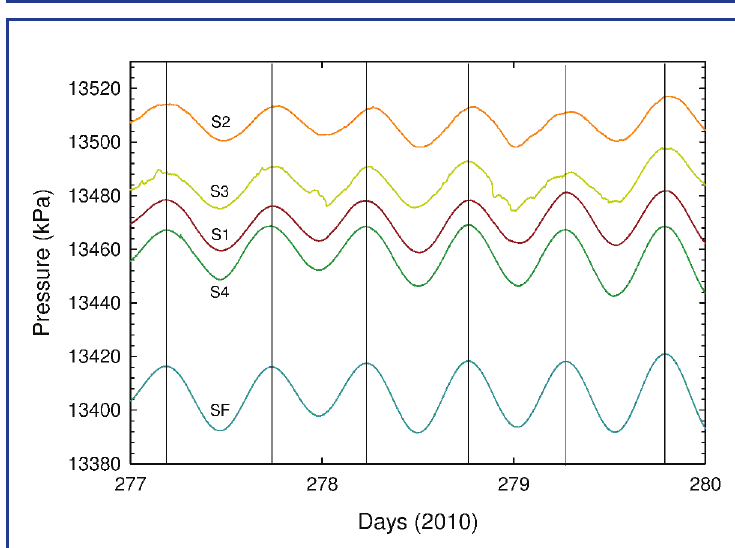
Figure 7. Three-day record of absolute seafloor and screen pressures, showing the dominant tidal component of variation. Differences in amplitudes and phases of pressure variations in the formation relative to pressure at the seafloor are discussed in the text. Lines at times of seafloor tidal peaks highlight the large phase lag of the signal at screen